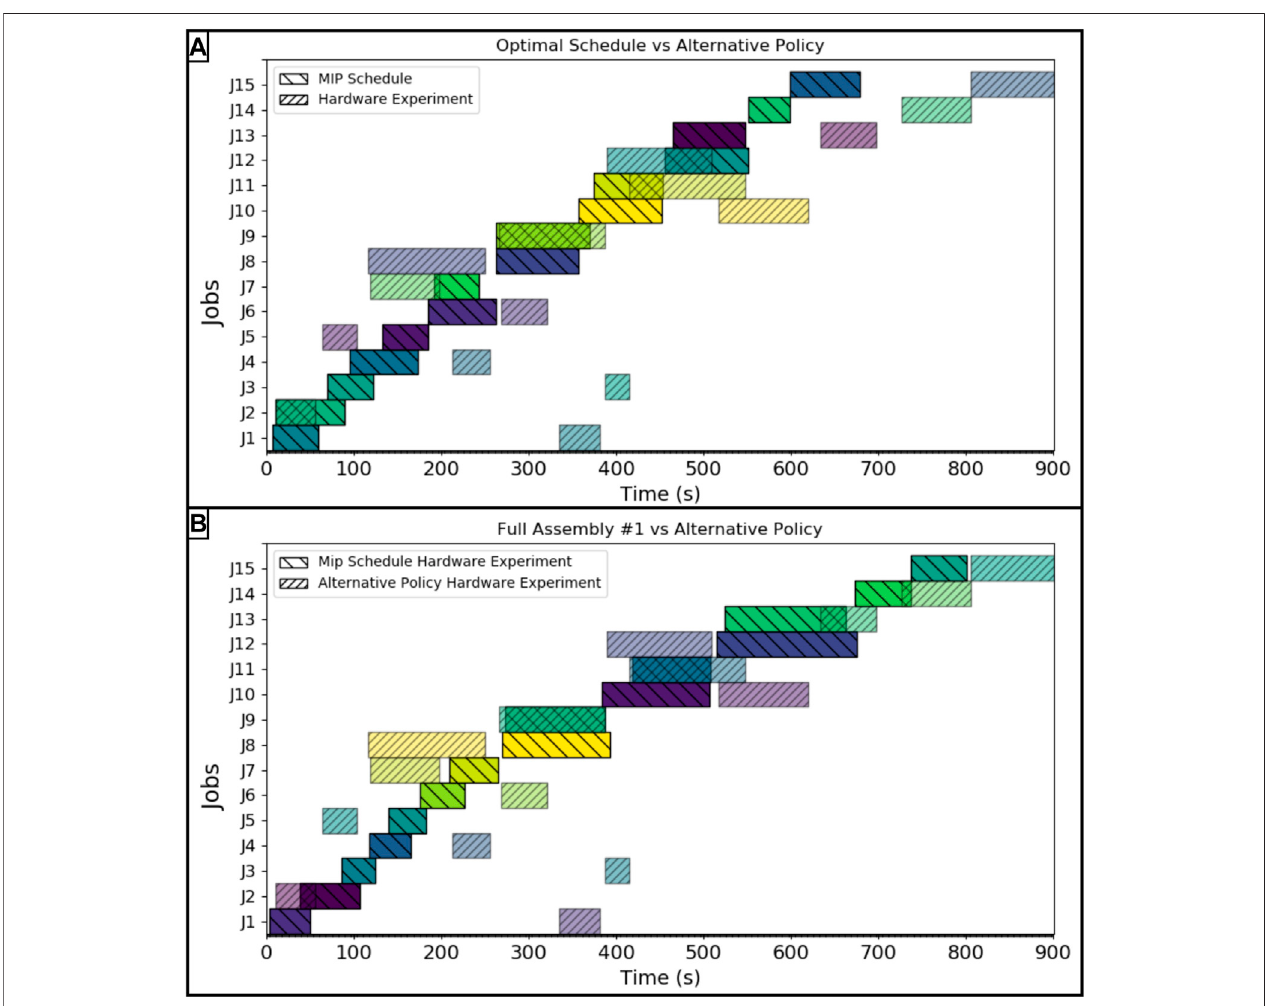
FIGURE 7 | (A) Hardware experiment following alternative policy compared against the optimal MIP scheduled, (B) Hardware experiment following alternative policy compared against hardware experiment following the optimal schedule. The job key is as follows: J 1: Mlb 2, J 2: Mlb 1, J 3: Mmb 2, J 4: Msbm 1, J 5: Mmb 1, J